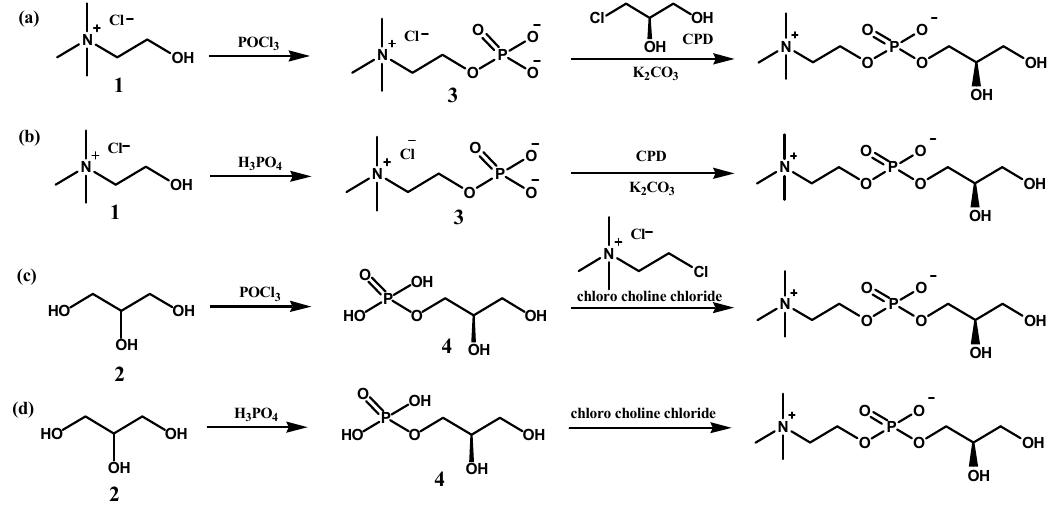
Figure 3. IR spectrum of choline